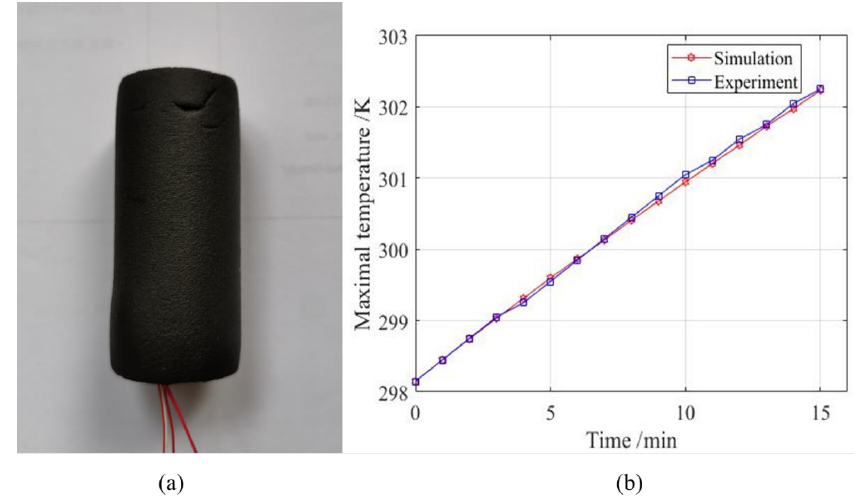
Figure 5. ( a ) The covered single battery. ( b ) Temperature rise of a single battery under an adiabatic